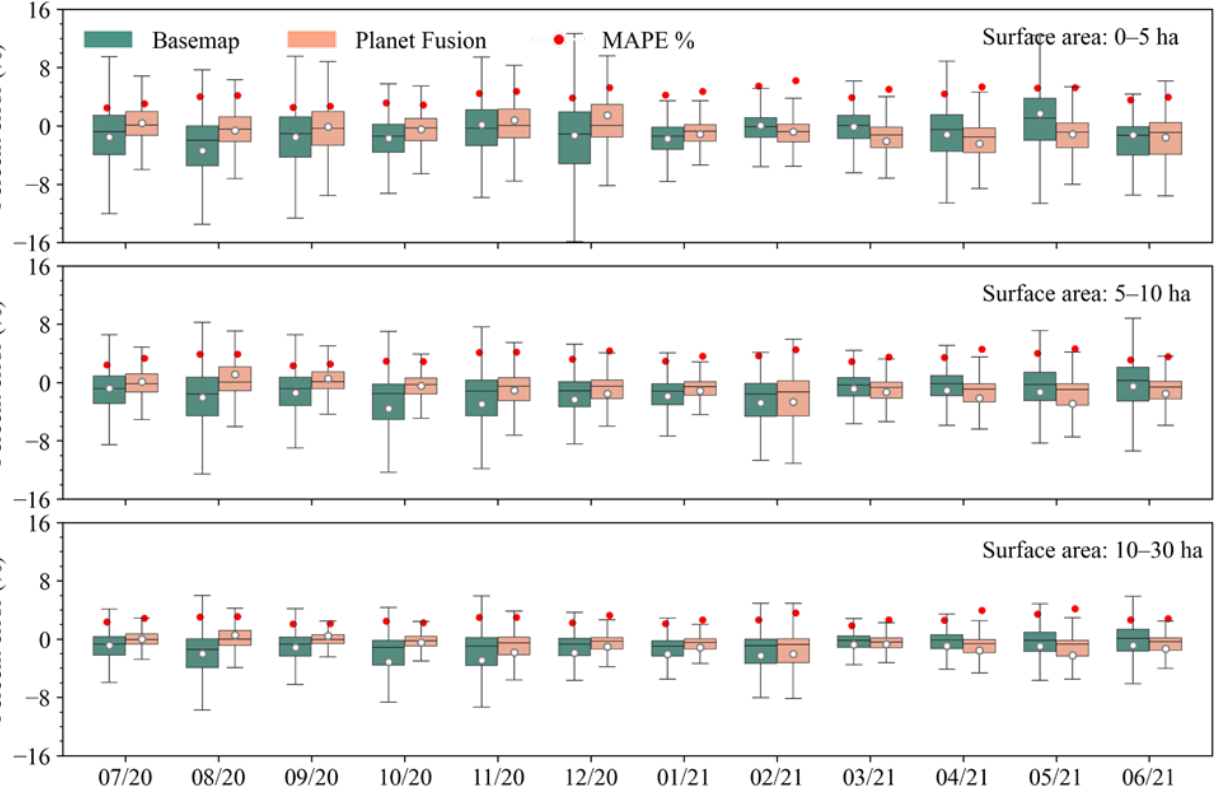
Figure 7. Monthly percent error variability and MAPE calculated from the same-day pairwise comparisons between Basemap and Planet Fusion with PlanetScope for the three size classes (0.1–5 ha, 5–10 ha, and 10–30 ha).